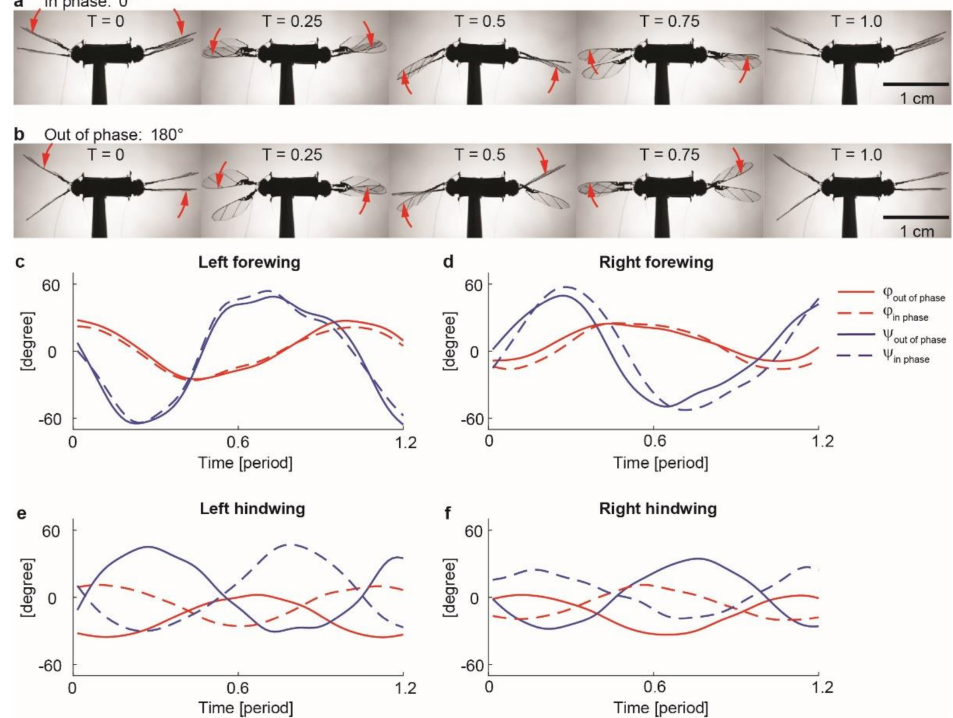
Figure 5. Comparison of in-phase and out-of-phase flapping kinematics. ( a , b ) Image sequences that show one period of in-phase ( a ) and out-of-phase ( b ) flapping experiments. The red arrows indicate the direction of wing stroke motion. ( c–f ) Tracked wing stroke ( φ ) and pitch ( ψ ) kinematics of the experiments shown in ( a , b